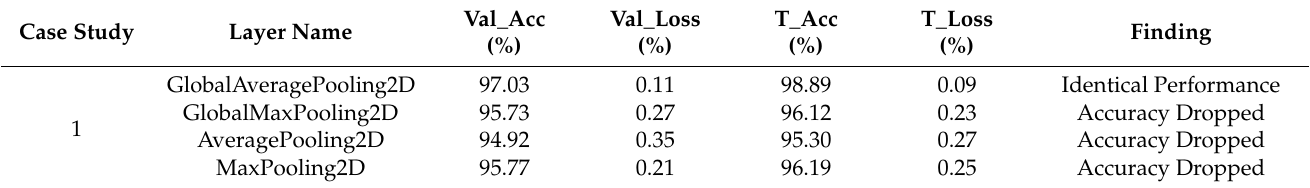
Table 6. Changing the GlobalAveragePooling2D (GAP2D) layer to evaluate the ablation